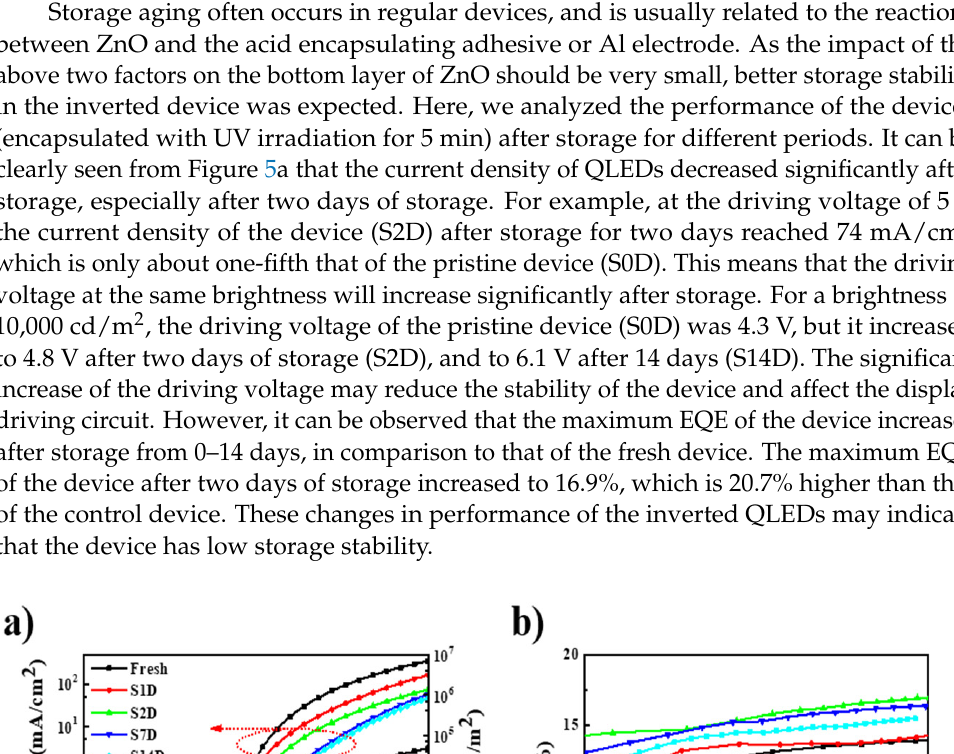
Figure 4. PLQY ( a ) and TRPL lifetime ( b ) of samples quartz/QDs, quartz/ZnO/QDs, and quartz/ZnO/QDs with UV irradiation.